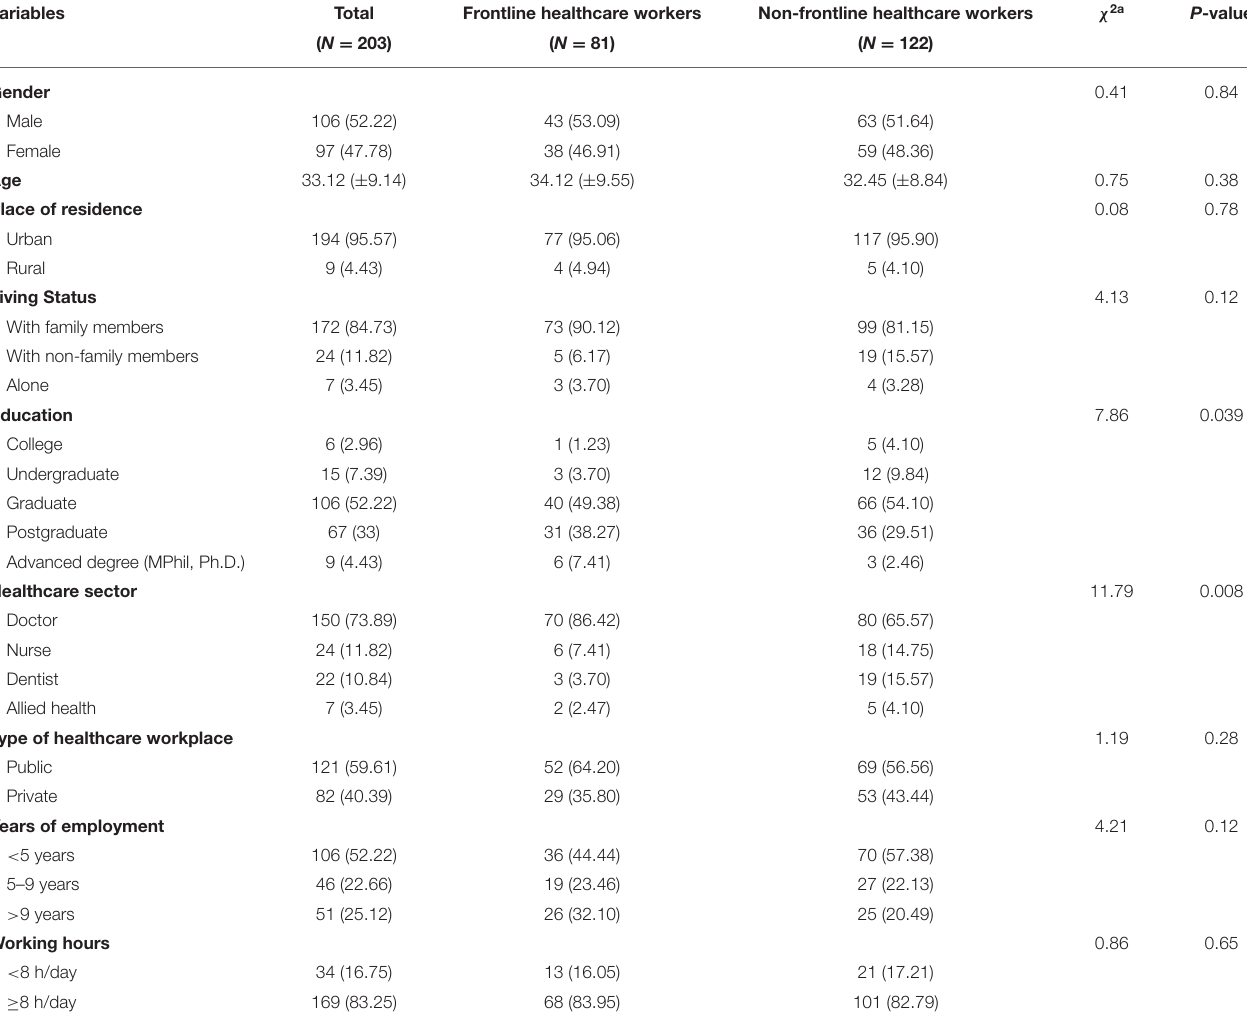
TABLE 1 | Descriptive statistics of respondents’ socio-demographic characteristics, residency, and employment